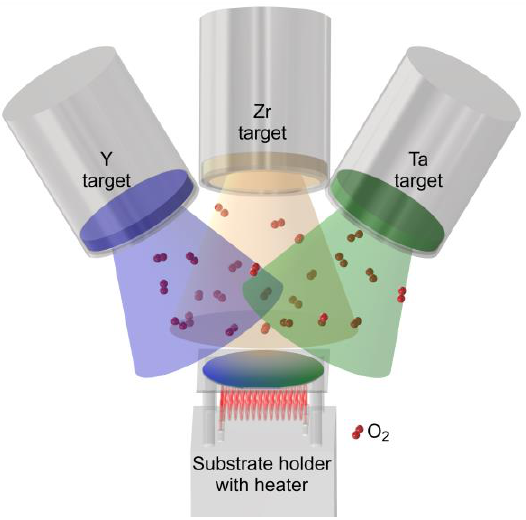
Figure 3. Schematic representation of deposition setup for reactive combinatorial magnetron sput- tering of Y, Ta, and Zr.